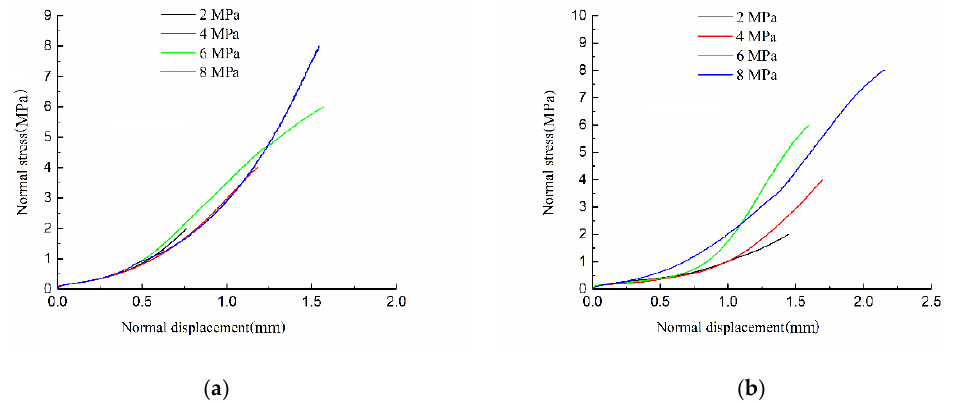
Figure 7. Stress–displacement curves for normal loading of grouted rock fracture ( a ) without gas occurrence and ( b ) with gas occurrence.